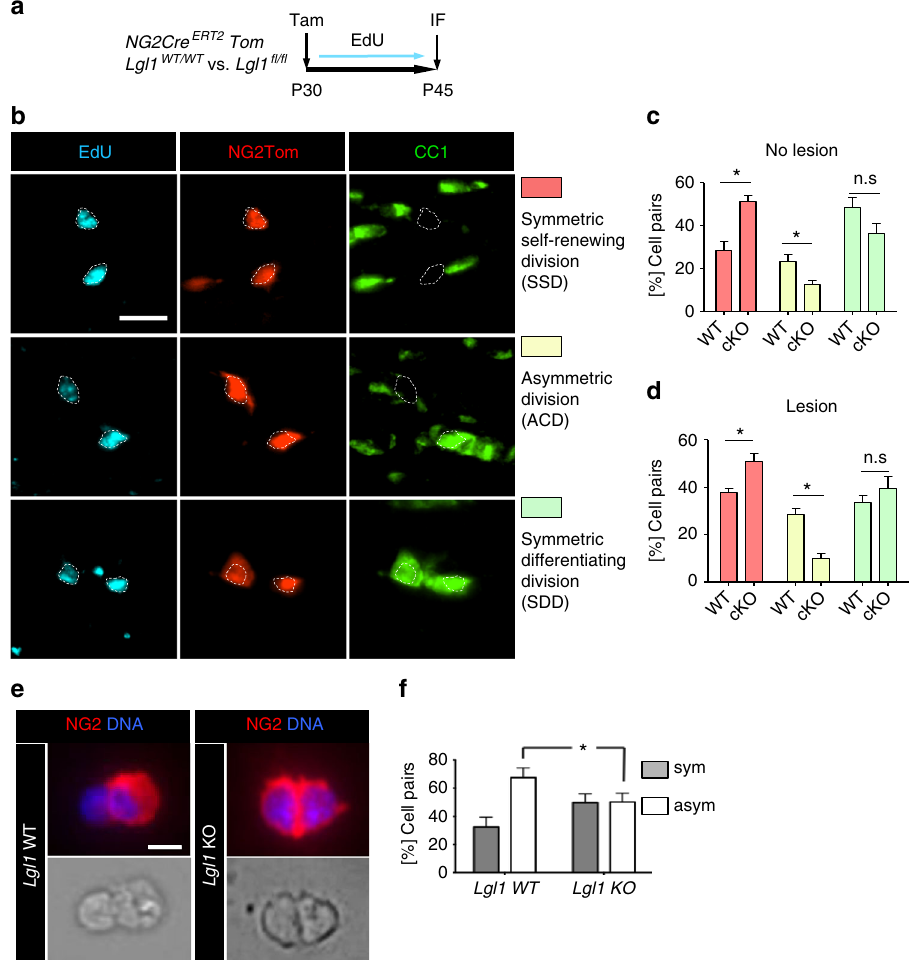
Fig. 3 Lgl1 regulates asymmetric cell divisions of OPC. a Treatment schematic for in vivo pair assay in P30 NG2-Cre ERT2 Tom Lgl1 WT vs. Lgl1 cKO mice, which were given EdU for 14 days in drinking water. b Left panels: Representative cell pairs in the corpus callosum of treated mice and co-immunostained for red fl uorescent protein (Tom) to label NG2 + cells and progeny, proliferation marker EdU and CC1. Symmetric, self-renewing divisions = two Tom + EdU + CC1 − progeny, asymmetric cell division = one Tom + EdU + CC1 − and one Tom + EdU + CC1 + progeny and symmetric, differentiating division = two Tom + EdU + CC1 + progeny. Scale bar: 10 µ m. c Graph depicting the frequency of each cell division mode and showing a signi fi cant decrease of asymmetric divisions (yellow bars) and an increase of symmetric, self-renewing divisions (red bars) in Lgl1 knockout (cKO) mice when compared with wildtype (WT) mice. Data are represented as mean ± s.e.m. from the analyses of 4 Lgl1 WT vs. 4 Lgl1 cKO treated mice ( n = 4, * p < 0.05, Mann – Whitney test). d Graph depicting the percentage of three division modes during remyelination in Lgl1 WT and Lgl1 cKO corpus callosum, and showing a signi fi cant decrease of asymmetric divisions (yellow bars) and increase of symmetric, self-renewing divisions (red bars). Data are represented as mean ± s.e.m. from the analyses of 4 Lgl1 WT vs. 4 Lgl1 cKO treated mice ( n = 4, * p < 0.05, Mann – Whitney test). e Representative NG2 + OPC pairs stained for NG2 (red) and DNA (blue) showing an asymmetric division in Lgl1 WT (left panel) and symmetric, self-renewing division in Lgl1 cKO (right panel) cells. Scale bar = 10 μ M. f Graph depicting percentage of cell pairs and showing that Lgl1 loss increases symmetric, self-renewing divisions at the expense of asymmetric divisions in vitro ( n = 6, * p < 0.05, Mann – Whitney